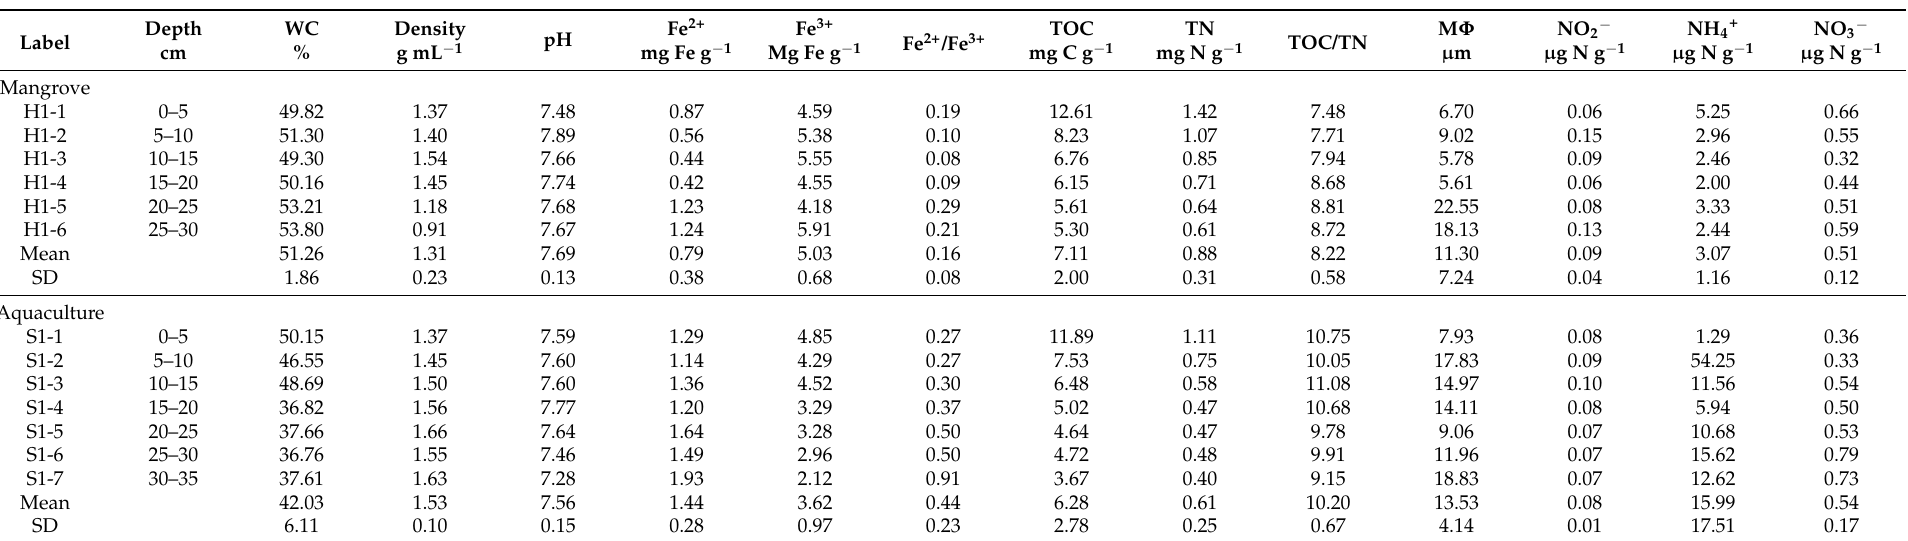
Table 1. Physicochemical properties of the sediments in reclamation aquaculture and mangrove